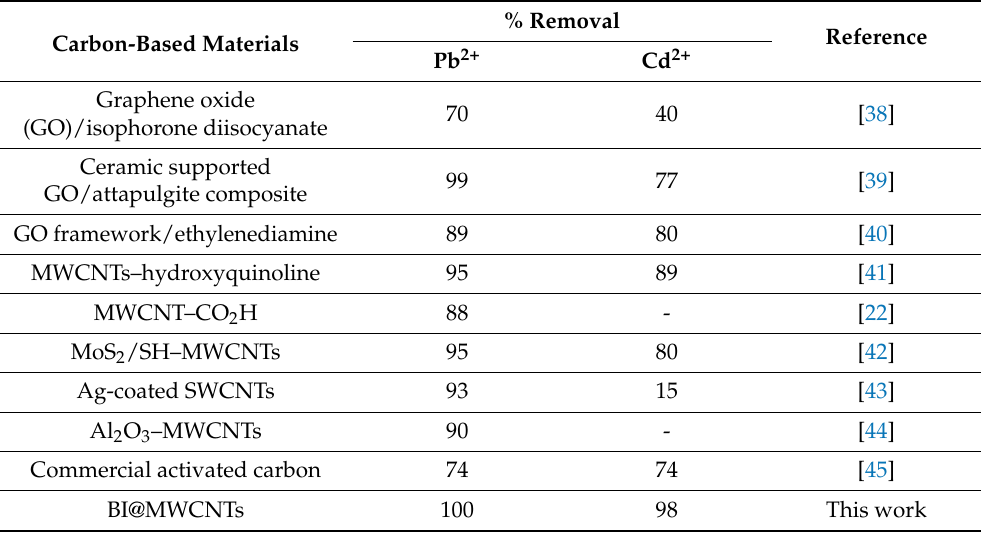
Table 6. Comparison between BI@MWCNTs and previously reported carbon-based adsorbents in terms of effectiveness at removing Pb 2+ and Cd 2+ from